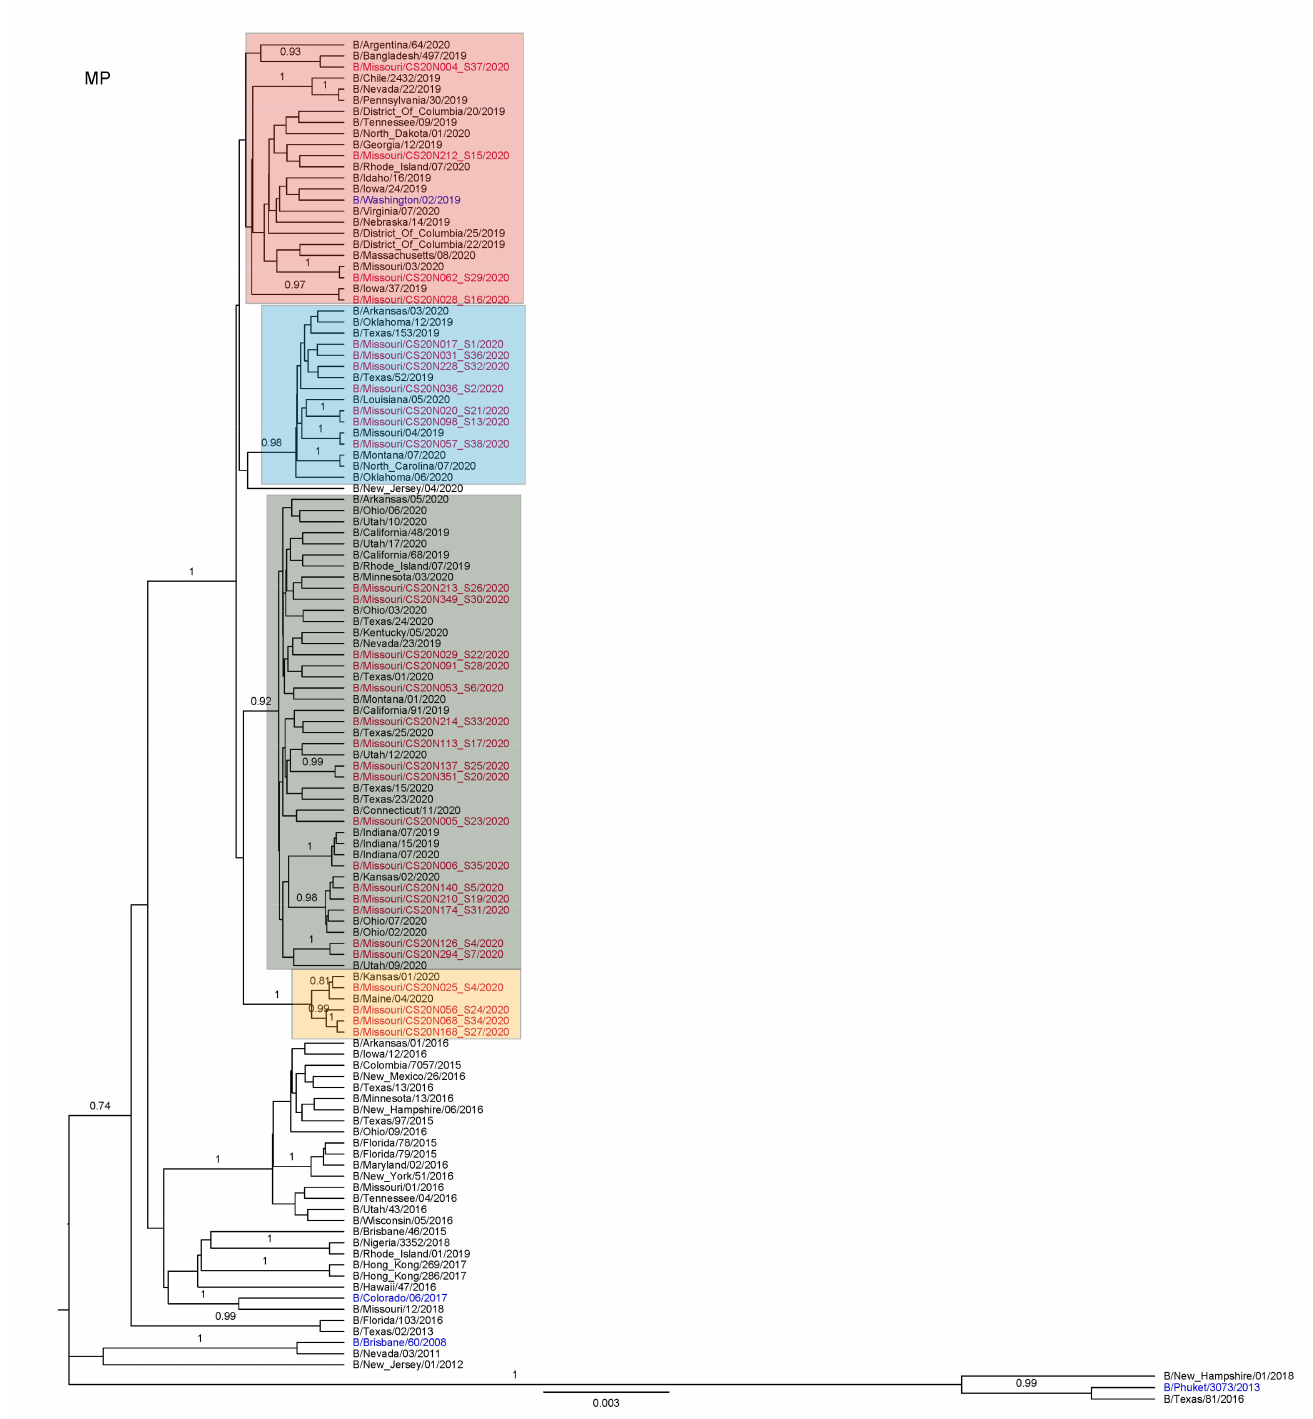
Figure A7. MP Tree. The phylogenetic analyses were performed by using BEAST2 with a Hasegawa–Kishino–Yano (HKY) substitution empirical model, strict clock model, and coalescent constant population prior. Branches with a posterior probability >0.70 were